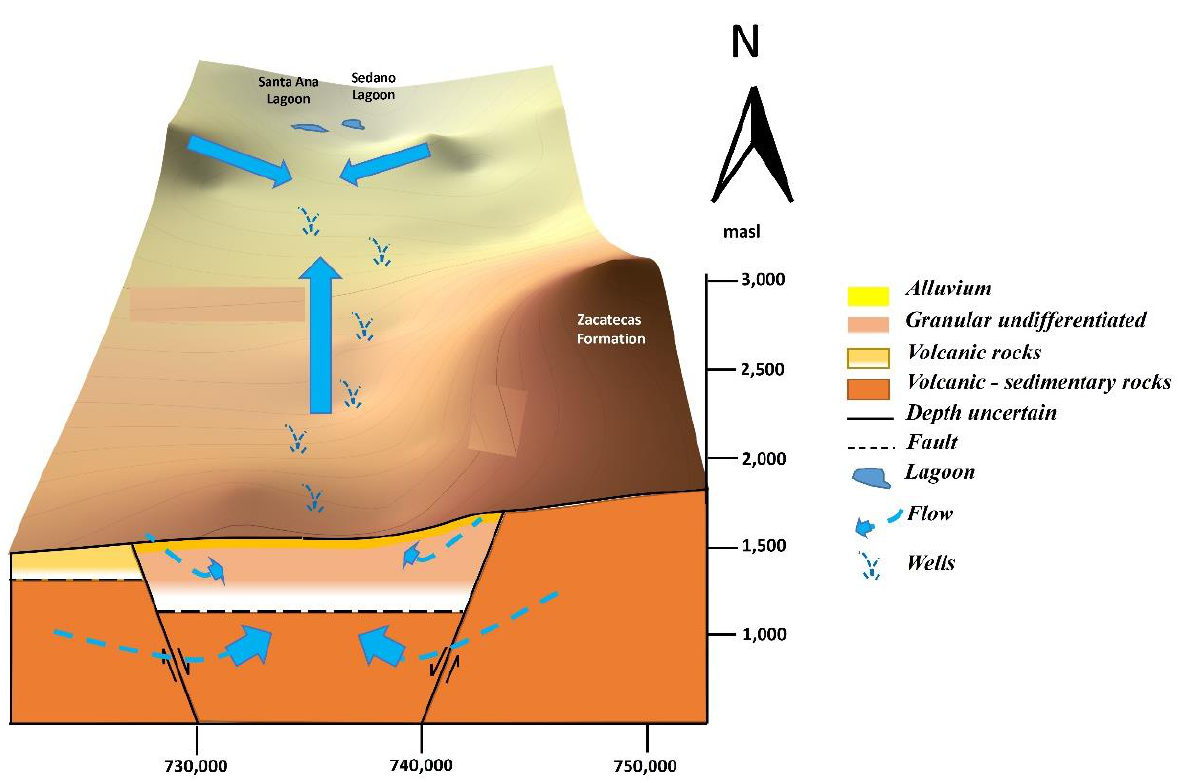
Figure 2. Schematic illustration of the Calera aquifer